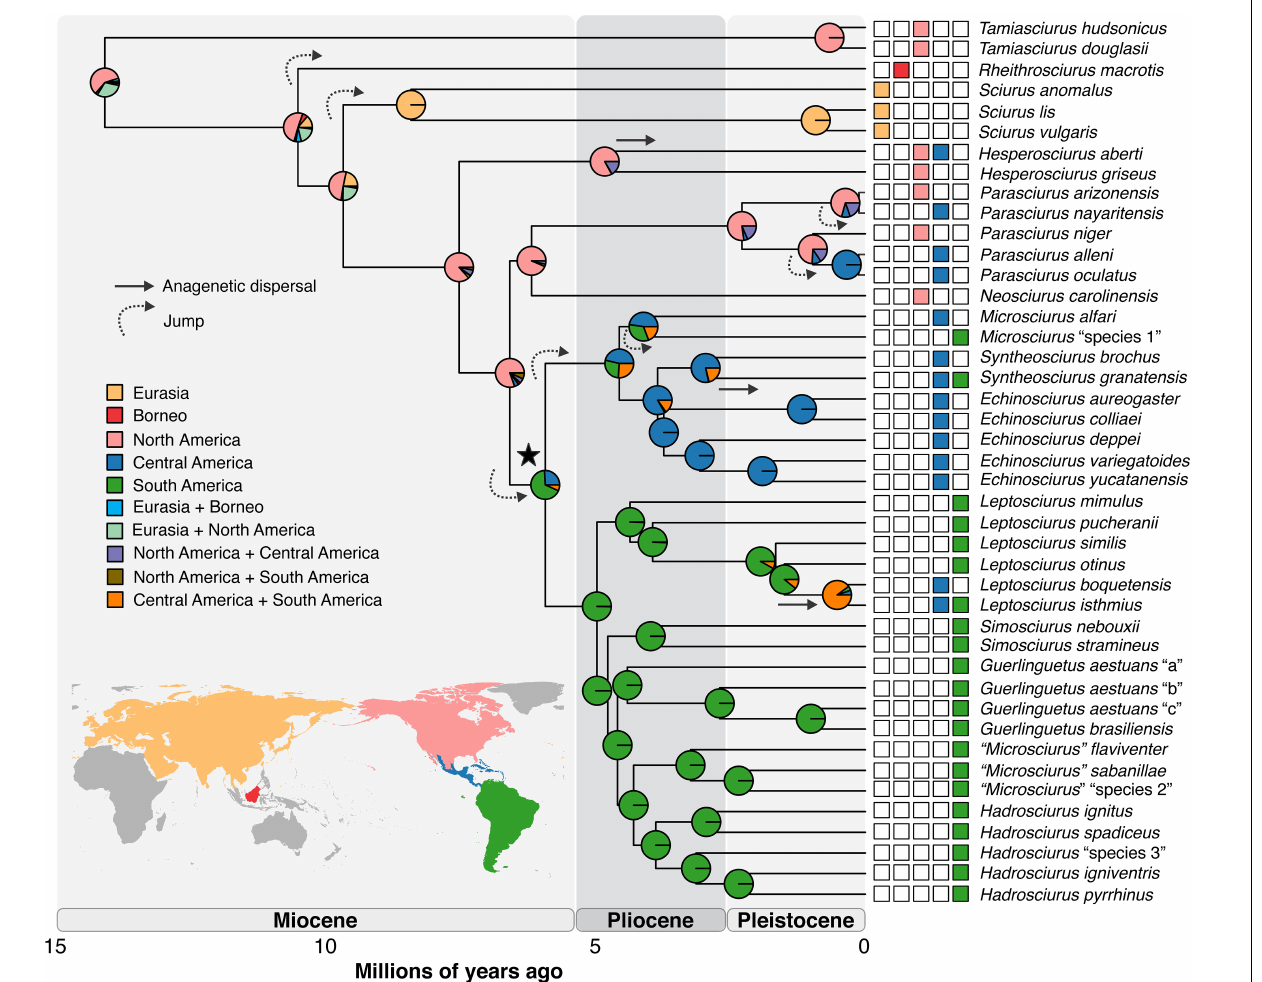
FIGURE 1 | Bayesian maximum clade credibility chronogram based on 13 mitochondrial protein-coding genes (11,278 bp) of 43 species of Sciurini and two species of Pteromyini used as outgroup (not shown). Ancestral ranges for Sciurini estimated by DEC + J model in the global scale analysis are illustrated. Colors in key boxes and map correspond to coloring of internal nodes (estimated probabilities of ancestral ranges) and terminal boxes (current distribution of species). Strait arrows denote anagenetic dispersal events and curved arrows designate founder-event speciation (jump). Black star identifies the node of Neotropical